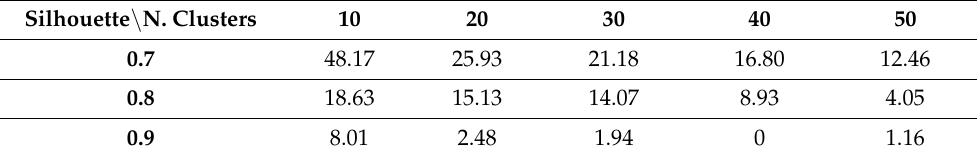
Table 47. Clustering performance in terms of silhouettes using the reduced dataset with PCA applied to normalized data.